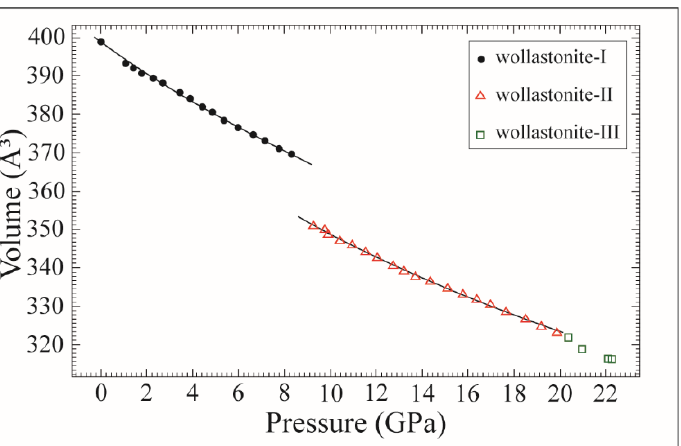
Figure 3. Evolution of the unit-cell volume with pressure of wollastonite. Unit-cell volume data of the two H P polytypes have been normalized to the low- P polytype. The solid line represents the 2nd order BM-EoS fit.